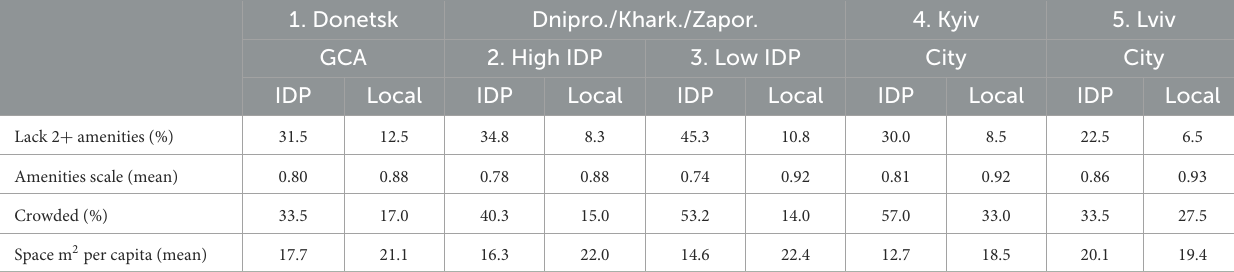
TABLE 6 Housing quality and quantity by zone (row